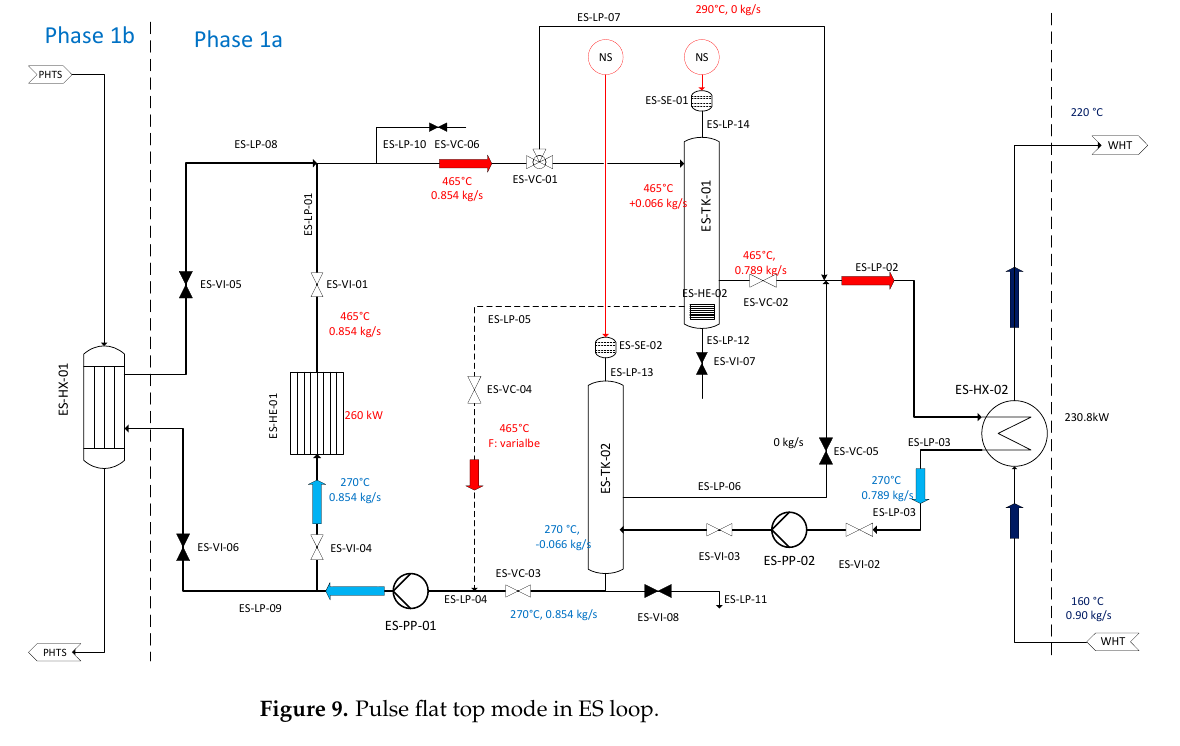
Figure 9. Pulse flat top mode in ES loop.